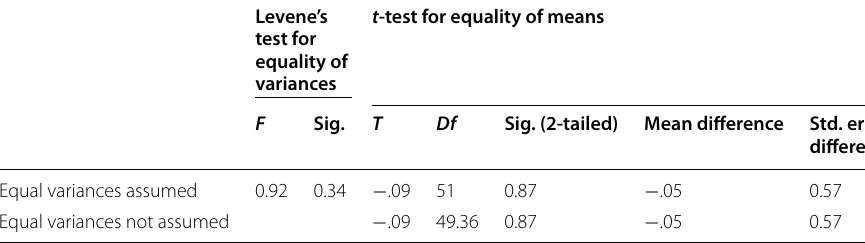
Equal variances not assumed